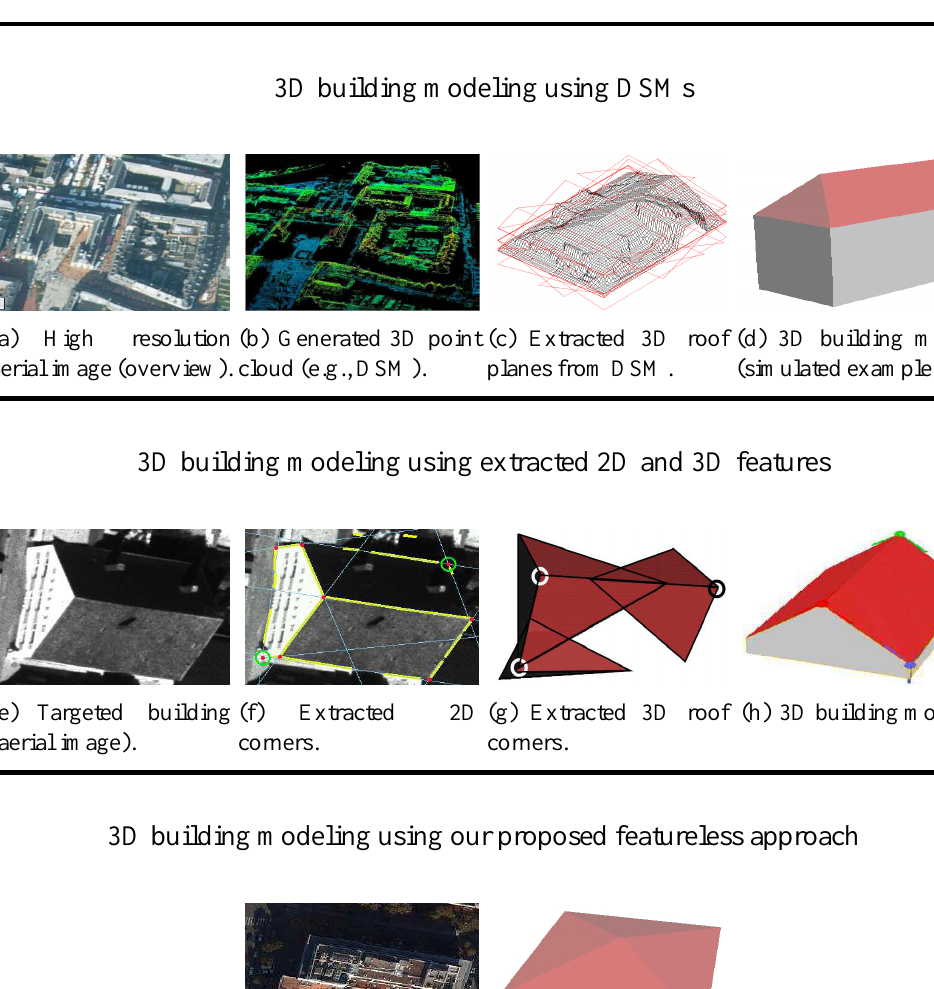
Figure 2. The upper part of this figure illustrates an example of 3D building modeling process using a DSM. The middle part of this figure shows image-based feature extraction and